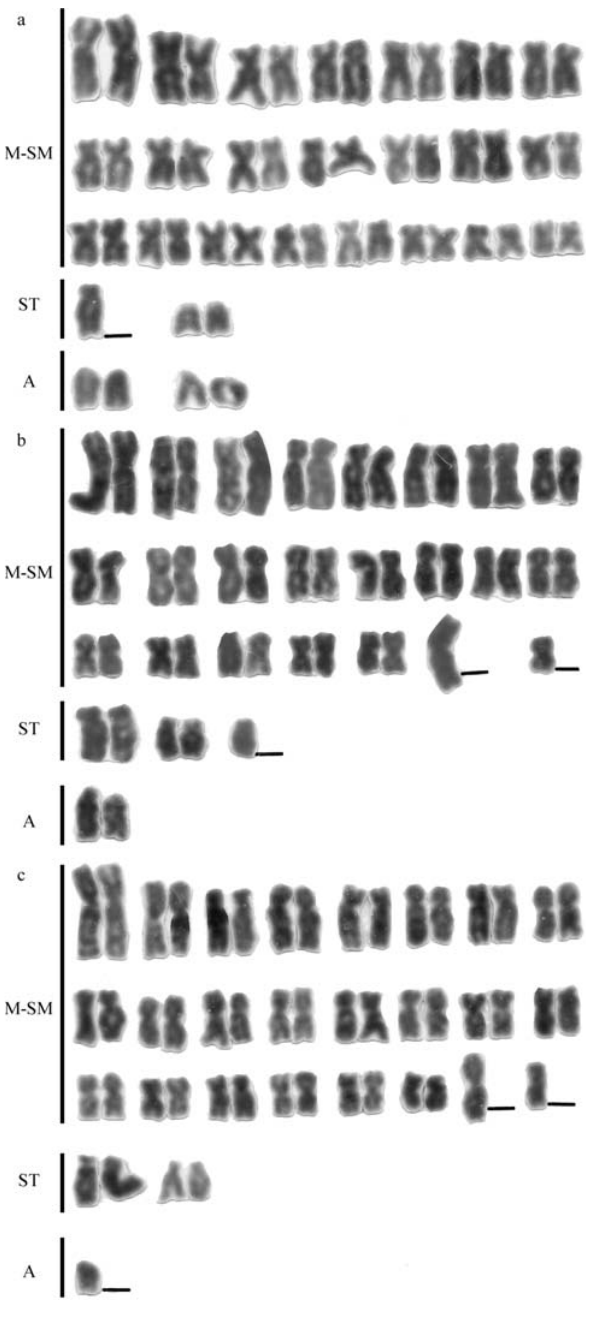
Figure 3 - Karyotypes of Prata river Hoplerythrinus unitaeniatus with 2n = 51 chromosomes, showing distinct structures (a-c). The dashes indi- cate an apparent lacking of